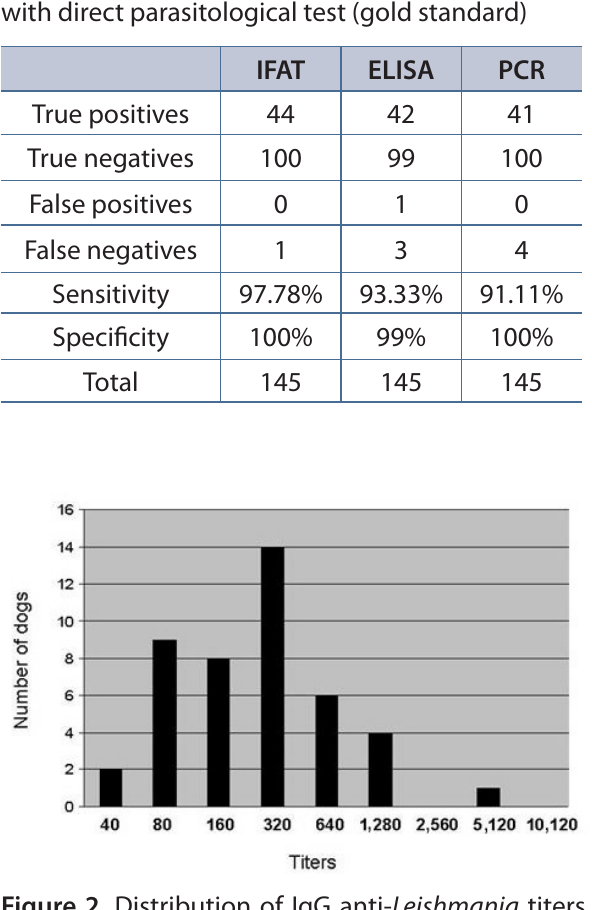
Figure 2. Distribution of IgG anti- Leishmania titers detected by IFAT in positive dogs (n = 44) from Bauru, SP,